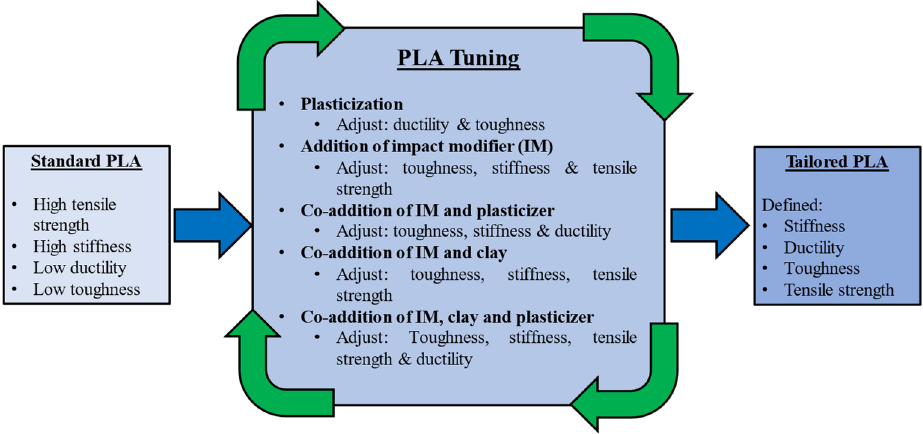
Figure 3. Tuning the properties of PLA with a variety of additives.